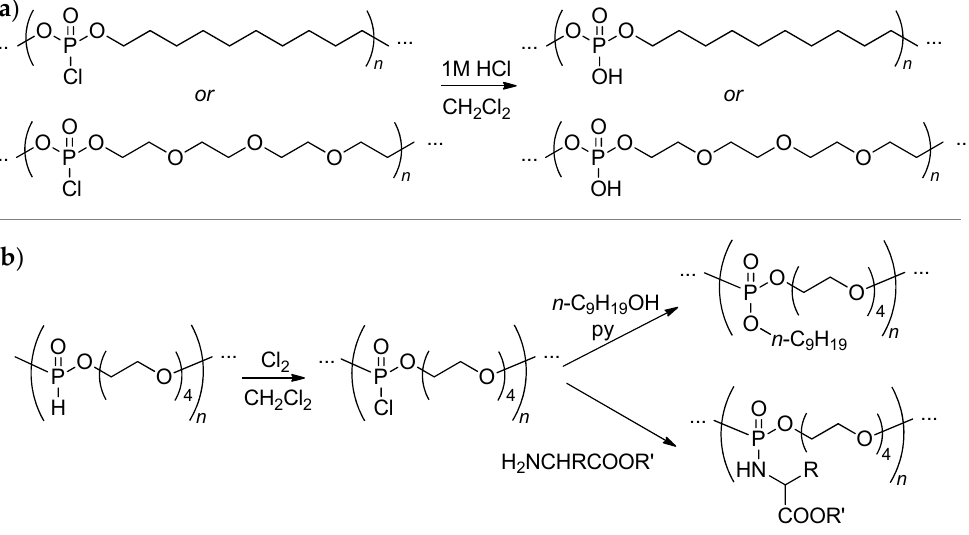
Scheme 6. Chlorination of poly(alkylene phosphonate)s followed by the: ( a ) hydrolysis [54]; or ( b ) reaction with alcohols [23] and amino acid esters [55]. Penczek and coll [56,57] have shown that the direction and selectivity of the hy- drolysis of poly(alkylene amidophosphate)s depend on the pH value and the structure of